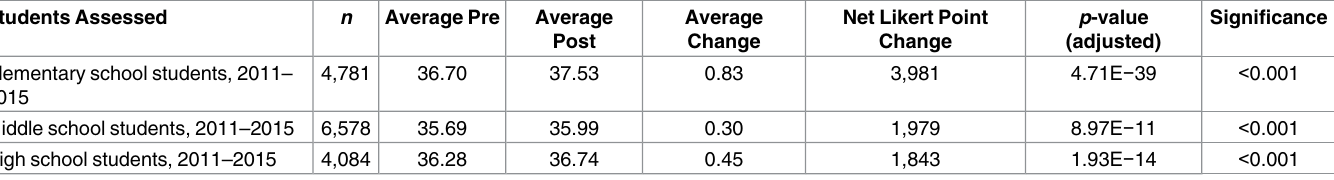
Data were processed by summing pre- and post-test values for each student across all test questions, except for question A3. Net Likert Point Change is the difference between the sum of all Likert scale values on pre- and post-tests. Significance is estimated using a two-sided Wilcoxon signed-rank test and family-wise error rate-corrected using the Bonferroni